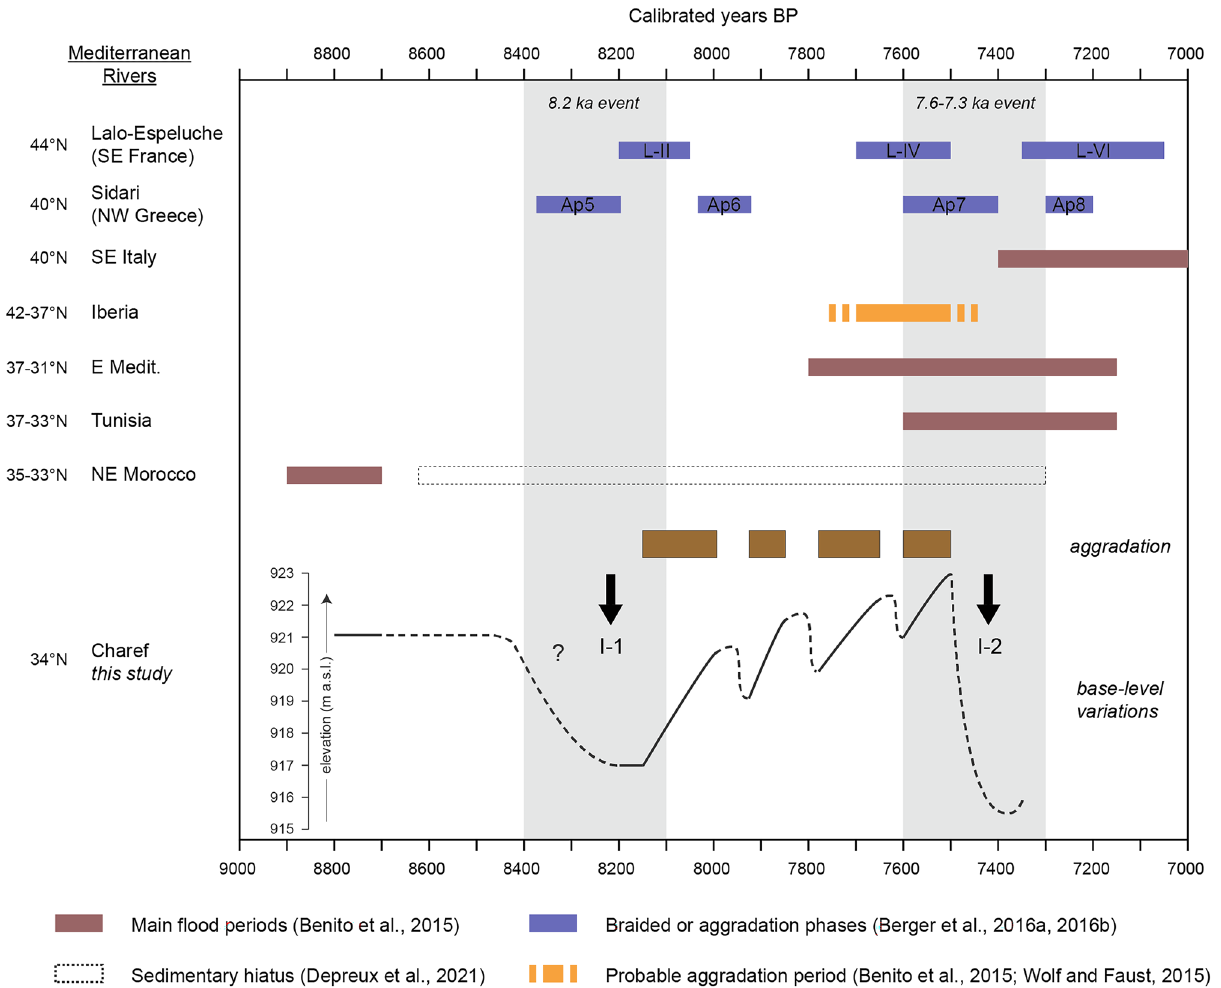
gap in NE Moroccan rivers from 8700 to 7300 cal. BP 25 , indices of aggradation in Iberia 21 , the braided phases identified at Lalo-Espeluche 18 , the aggradation phases identified at Sidari 19 , and the base-level variations of the Charef River with the I-1 and I-2 incision phases and the four aggradation